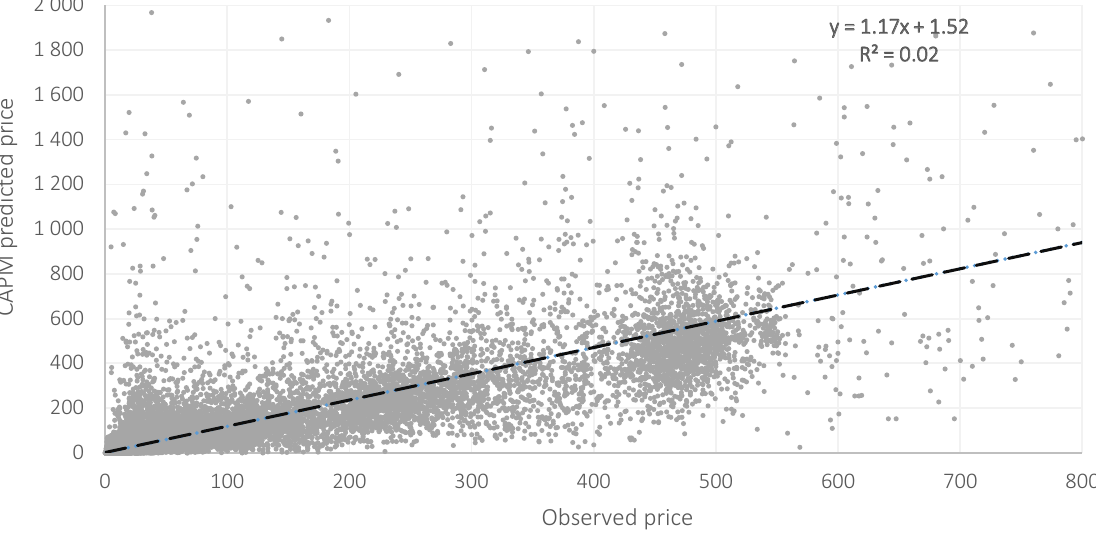
Figure 2. CAPM predicted asset prices vs actual observed